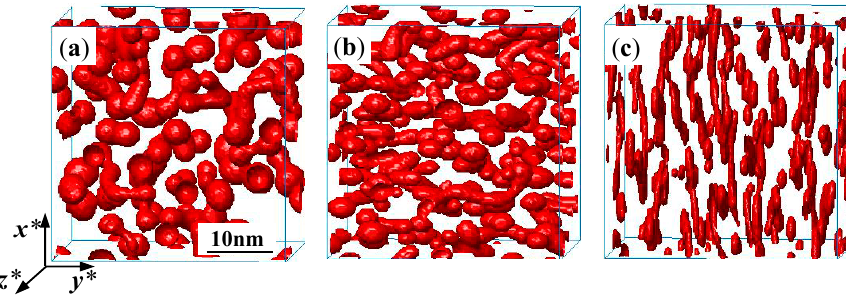
Figure 3. The morphology of α′ phase in the Fe-28 at. % Cr alloy aged at 750 K for t = 1150 h. ( a ) without applied strain ε a xx = 0.0, ( b ) tensile strain ε a xx = 0.02, ( c ) compressive strain ε a xx = − 0.02. Table 1. The Cr concentration (at. %) in α and α (cid:48) phase of Fe-28 at. % Cr alloy aged at 750 K with and without applied strain. Strain α (at. % Cr) α (cid:48) (at. % Cr) ε a xx = −